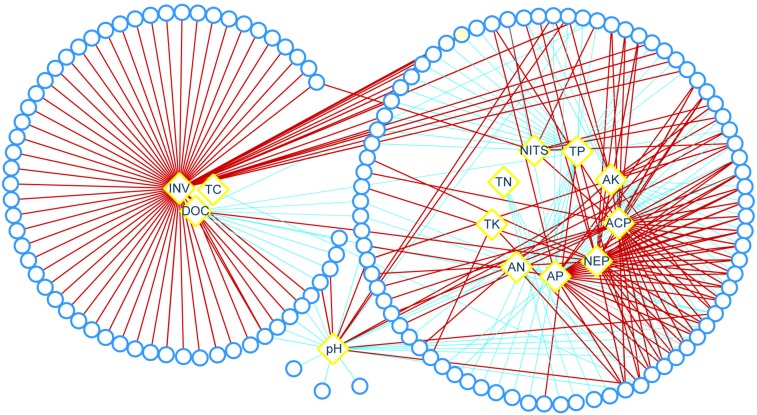
Relationships between bacterial community and soil properties. Red and blue lines represent significant positive and negative correlations, respectively (| Spearman’s ρ| > 0.60; P < 0.05), the width of the lines is proportional to the value of Spearman’s ρ, Round represents bacterial genus, rhombus represents soil property. ACP, acid phosphatase; AK, available potassium; AN, available nitrogen; AP, available phosphorus; DOC, dissolved organic carbon; INV, invertase; NEP, neutral phosphatase; NITS, nitrogenase; TC, total carbon; TK, total potassium; TN, total nitrogen; TP, total phosphorus.